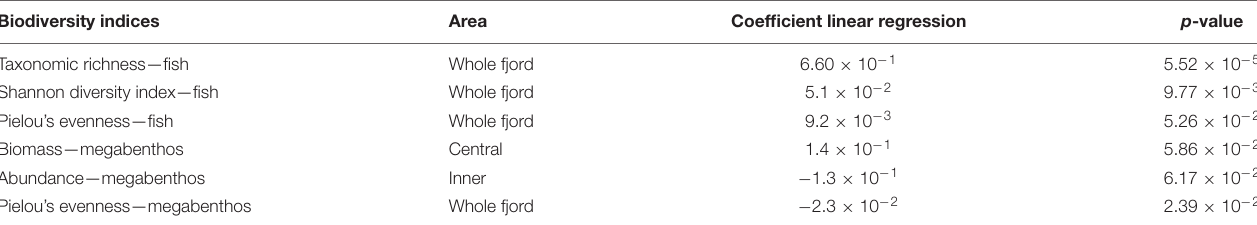
TABLE 2 | Coefficient and p -value of the linear regression of the biodiversity indices (taxonomic richness, log(x + 1) transformed stratified biomass, log(x + 1) transformed stratified abundance, Shannon diversity, and Pielou’s evenness) for megabenthic and fish taxa over time. Biodiversity